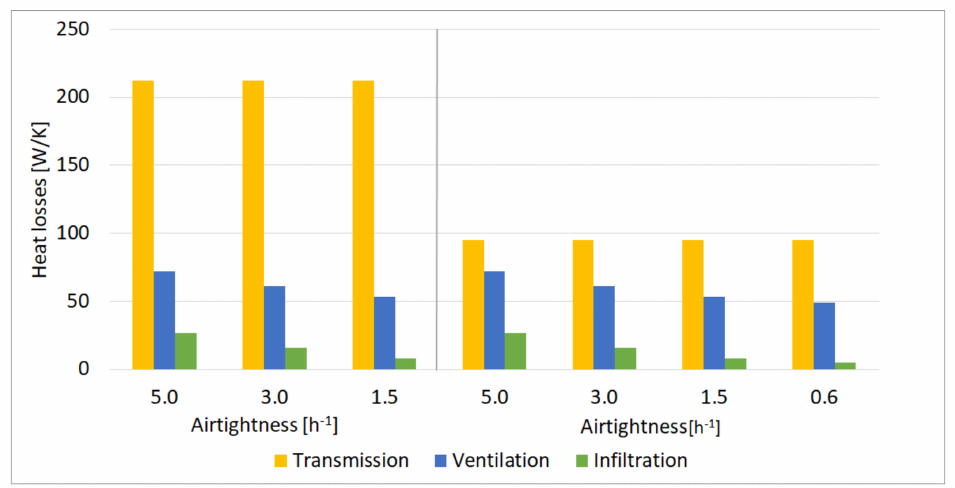
Figure 2. Transmission, ventilation, and infiltration heat losses for exemplary single-family building in the climate of Poland, assuming different airtightness, prepared based on data from [2].